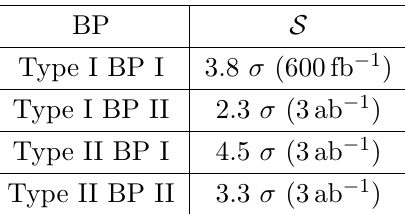
300 fb (cid:0) 1 in this case. Comparing tables 4 and 6 we can see that for all the benchmark points that we considered VBF supersedes the gluon fusion channel. Although gluon fusion cross section is larger than the VBF cross section, the VBF channel has better separation between signal and background. Consequently the VBF channel seems to have better prospect than gluon fusion channel while looking for decay of heavy Higgs in the invisible mode.